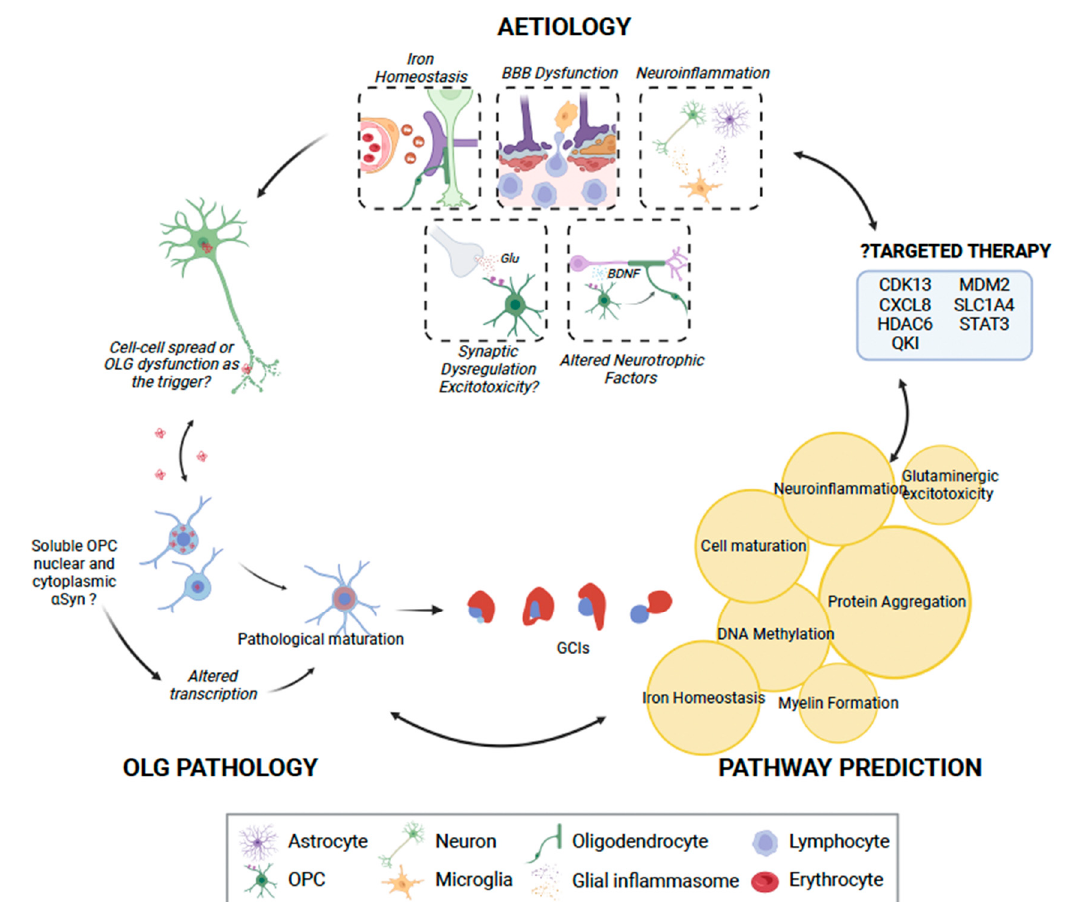
Figure 2. The role of oligodendrocyte lineage cells (OLCs) in MSA pathogenesis. While OPCs may not be able to uptake insoluble α -synuclein, they may play a role in pathogenesis by